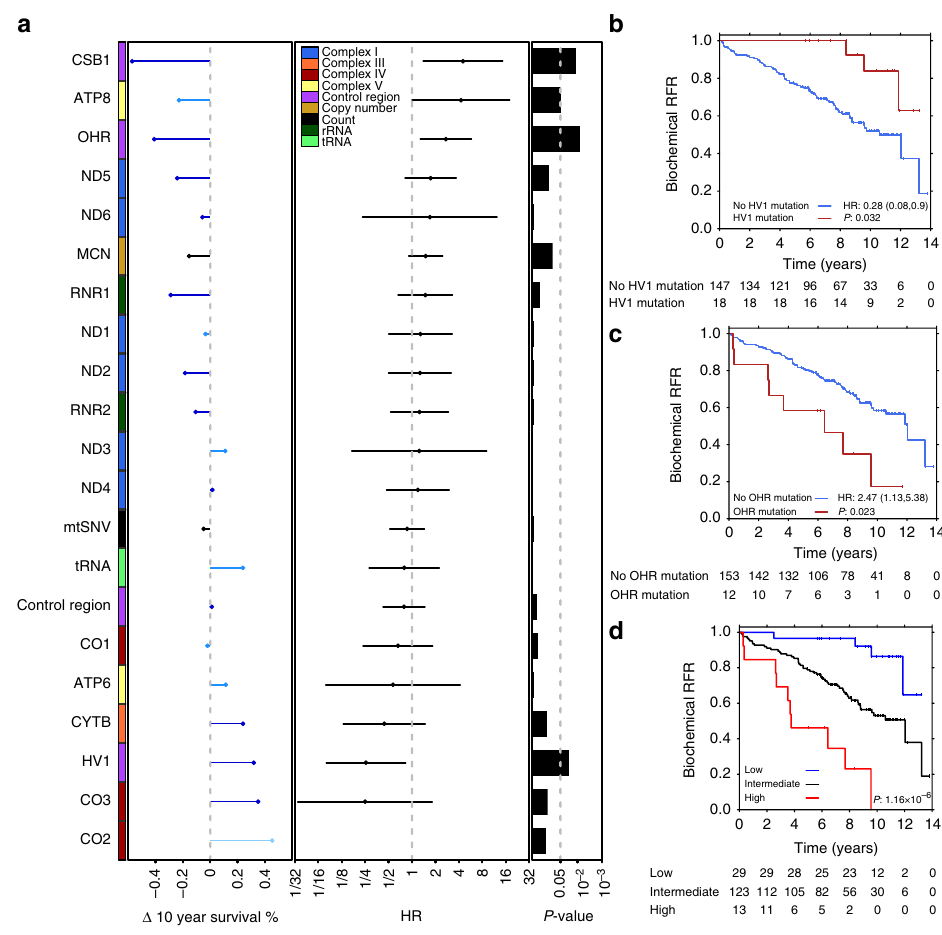
Fig. 4 Clinical impact of mitochondrial mutations in prostate cancer. a The associations of biochemical recurrence (BCR) and 21 mitochondrial features: 19 mitochondrial genes or regions, MCN (median-dichotomized), and mtSNV count (0 vs. 1 + ) were calculated using Cox models in 165 LOPC patients. Hazard ratios (HRs) are shown in the middle panel and P -values from the log-rank test in the right panel . The change in the 10-year survival for patients with mutations in each mitochondrial region is indicated ( left panel ). The color of the bars indicate the average Δ HF for mtSNVs in that region; light-blue 20 – 40%, medium-blue 40 – 60%, dark-blue ≥ 60%. b Kaplan – Meier plots of mtSNVs occurring within HV1 and ( c ) OHR. d Kaplan – Meier plot of results of leave-one-out cross-validation predictions ( P -value from log-rank